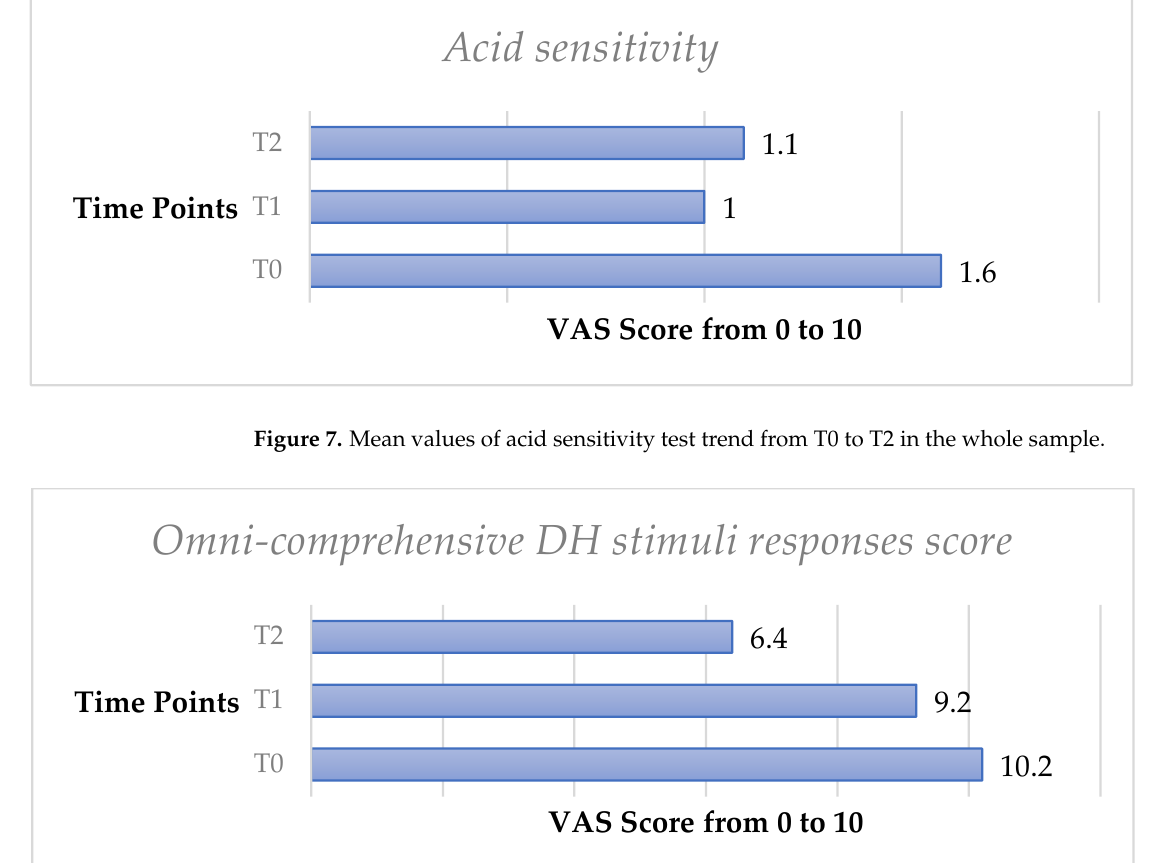
Figure 6. Mean osmotic sensitivity test from T0 to T2 in the whole sample.